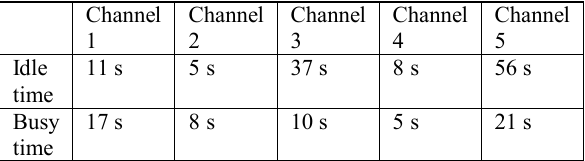
Figure 6. Measured throughput and number of channel changes with all the methods, random interference traffic. Table I. Idle and busy periods for used channels.